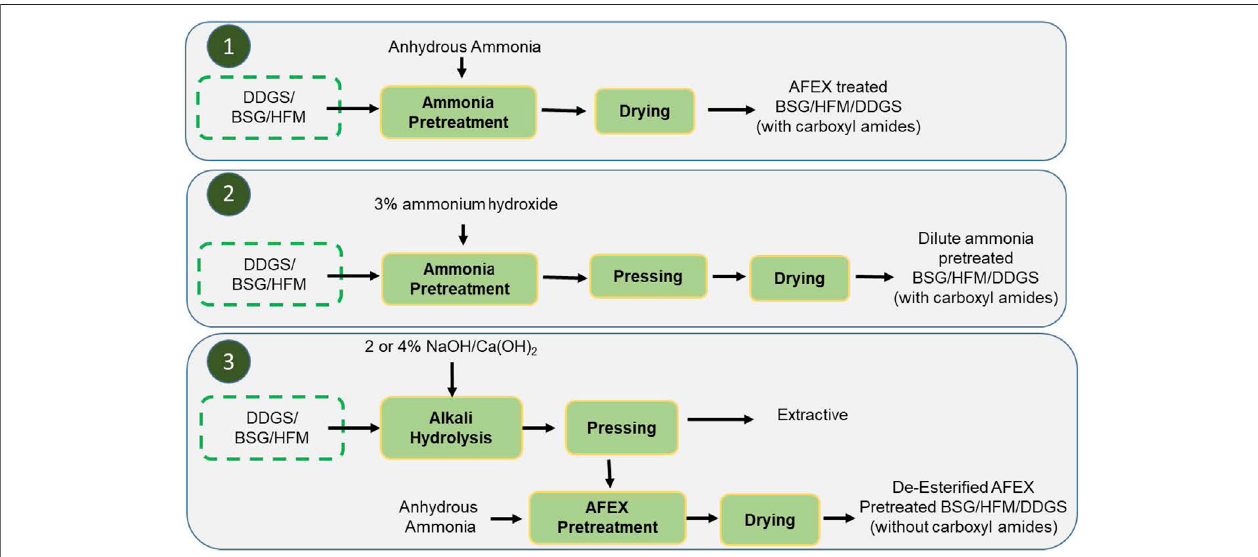
FIGURE 4| Three different scenarios ofalkali treatment of BSG/HFM/BSG. Here, 1, AFEX pretreatment process; 2, dilute ammonium hydroxide pretreatment and 3, either 2 or 4% NaOH, Ca(OH) 2 pretreatment followed by anhydrous ammonia pretreatment. Scenarios 1 and 2 produce carboxamides in pretreated biomass, while scenario 3 produces pretreated biomass without carboxamides.